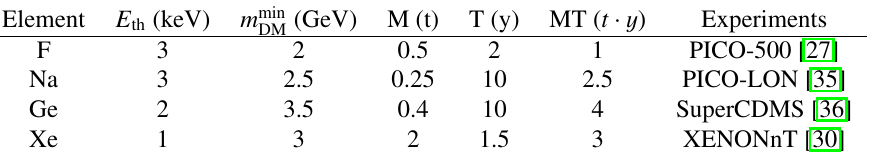
Table 1. Experimental values used in the numerical analysis for future direct detection experiments. Columns 2 to 6 show respectively the recoil energy threshold E th (keV), the minimum DM mass that can be detected in GeV, the mass of the detector M in tonnes, the data collection time T in years and the total exposure MT ( t · y ). The last column shows an illustrative experimental reference for the type of experiment considered. For xenon we consider both isotopes Xe 129 and Xe 131 with mass fractions x j equal to 0 . 264 and 0 . 212, respectively.